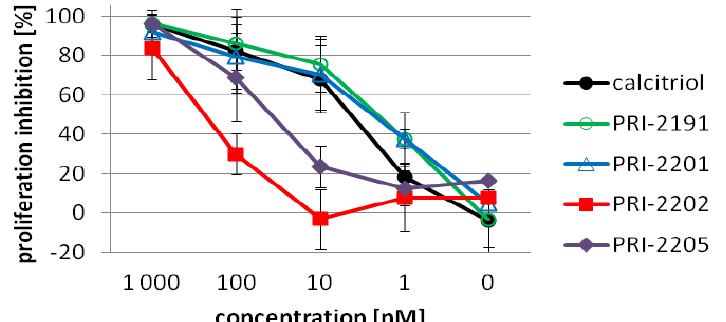
Figure 2. The proliferation inhibition of HL-60 cells by calcitriol or its analogs after 72 h incubation. HL-60 cells were exposed to calcitriol or the PRI-2191, PRI-2201, PRI-2202, PRI-2205 (1000, 100, 10, 1, 0.1 nM) for 72